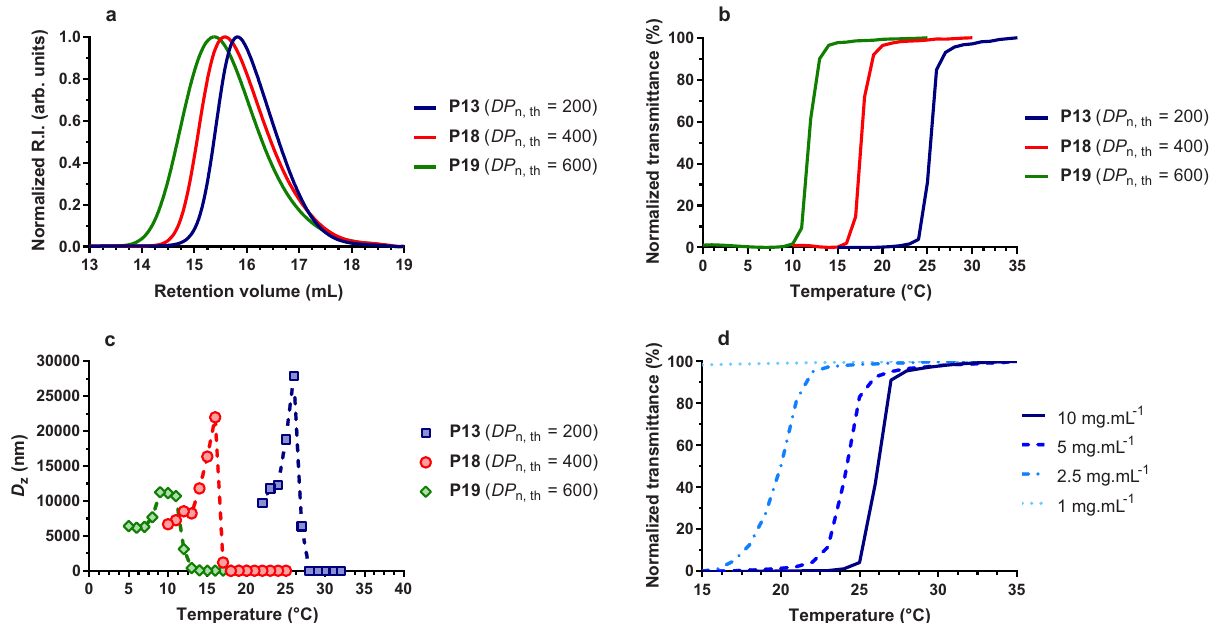
Fig. 5 Tuning the UCST of P(AAm- co -BMDO) copolymers. a Evolution of the SEC chromatograms of P(AAm- co -BMDO) copolymers with the targeted average degree of polymerization ( DP n, th ); b variation of the solution transmittance vs. temperature of P(AAm- co -BMDO) copolymers P13 and P18 – P19 solution in water at 10 mg mL − 1 upon cooling (1 °C min − 1 ); c Variation of the intensity average diameter ( D z ) from DLS vs. temperature of P(AAm- co - BMDO) copolymers P13 and P18 – P19 in solution in water (10 mg mL − 1 ) upon cooling (1 °C min − 1 ) during temperature cycling; d variation of the solution transmittance vs. temperature of P(AAm- co -BMDO) P13 at different concentrations in water, i.e., 1, 2.5, 5, and 10 mg mL − 1 upon cooling (1 °C min − 1